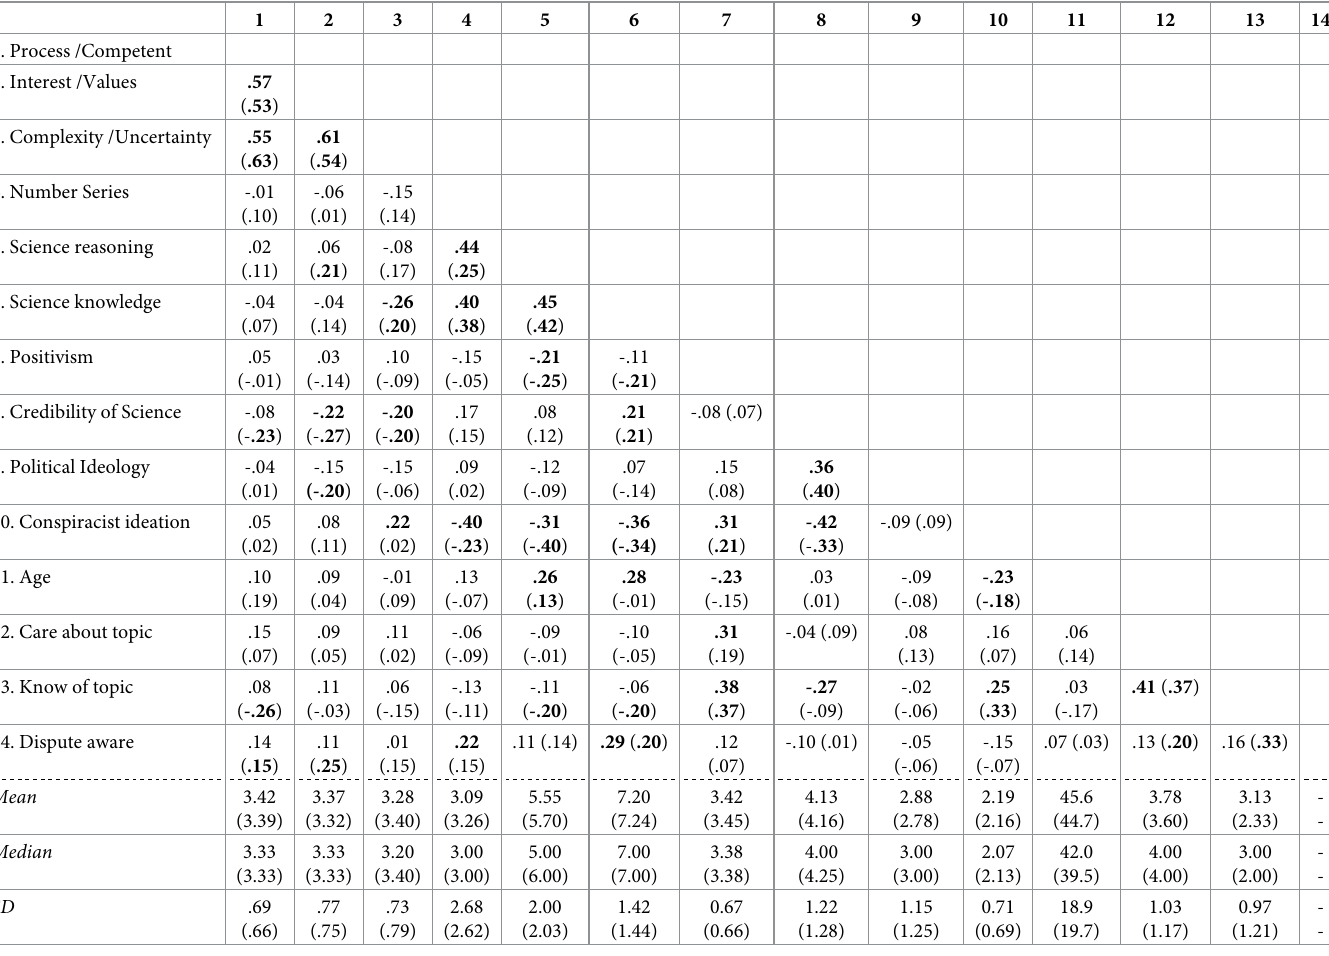
Table 3. Study 2. Pearson correlations for participants who read the Salt ( n = 201) and Nanotechnology ( n = 172)